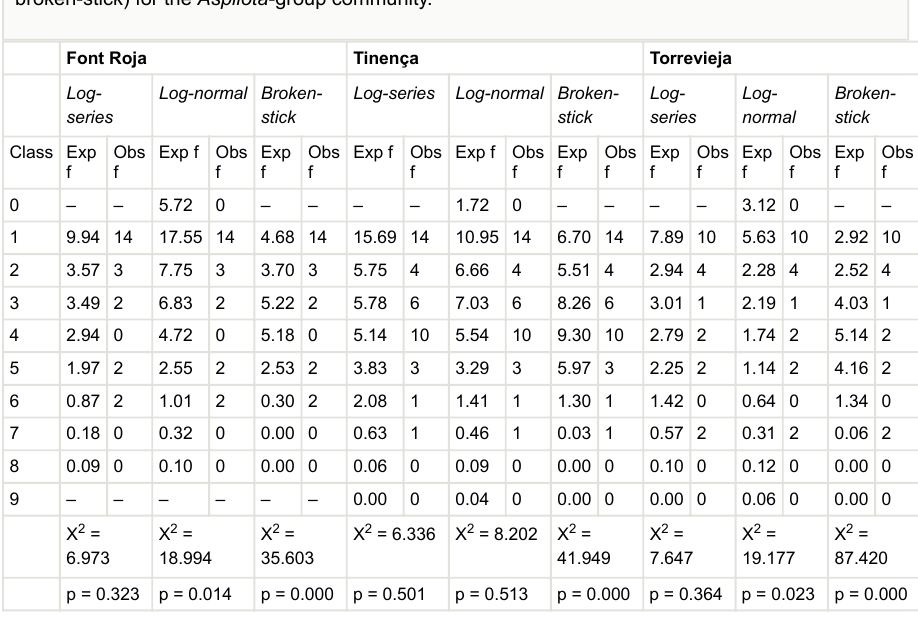
Expected frequency of species (exp f) according to abundance models (log-series, log-normal and broken-stick) for the Aspilota -group